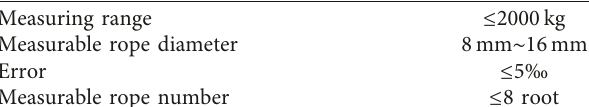
Figure 3: Braking torque—acceleration relation diagram. Table 4: Parameters of elevator quality-testing